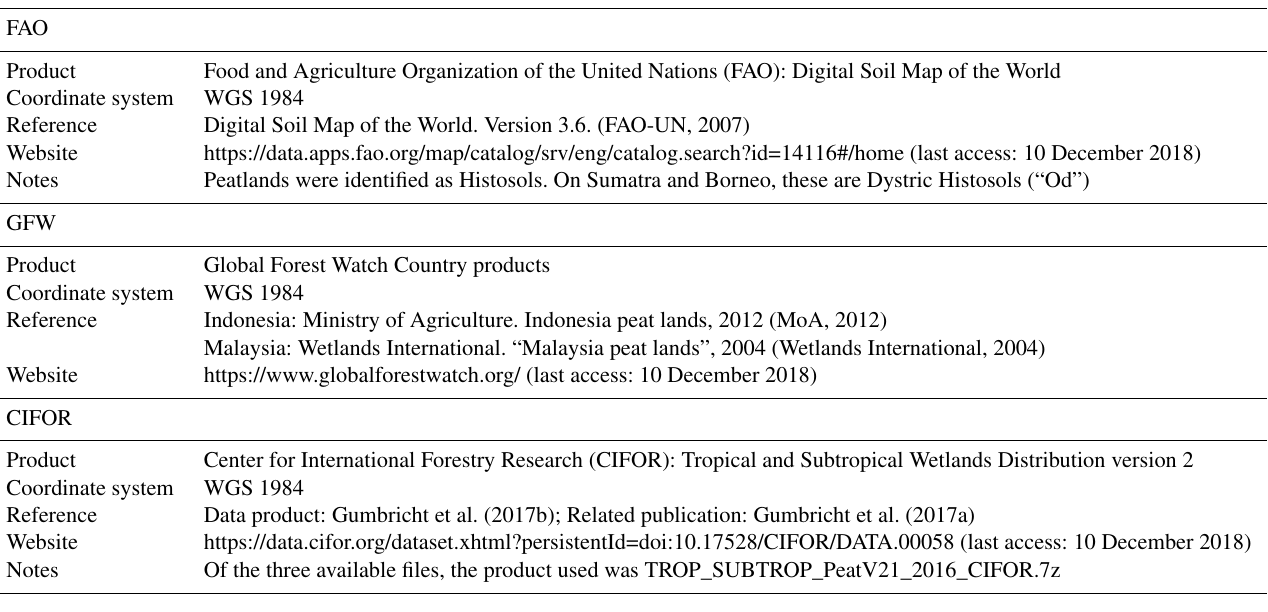
Table C1. Different data products used to assess peatland extent in the catchments.